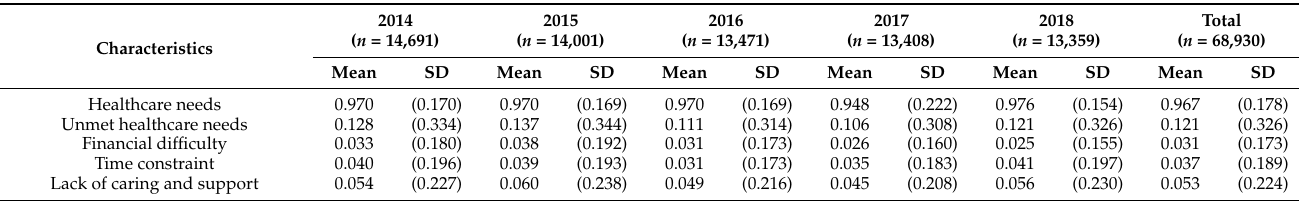
Table 1. Sample characteristics and their descriptive statistics for each